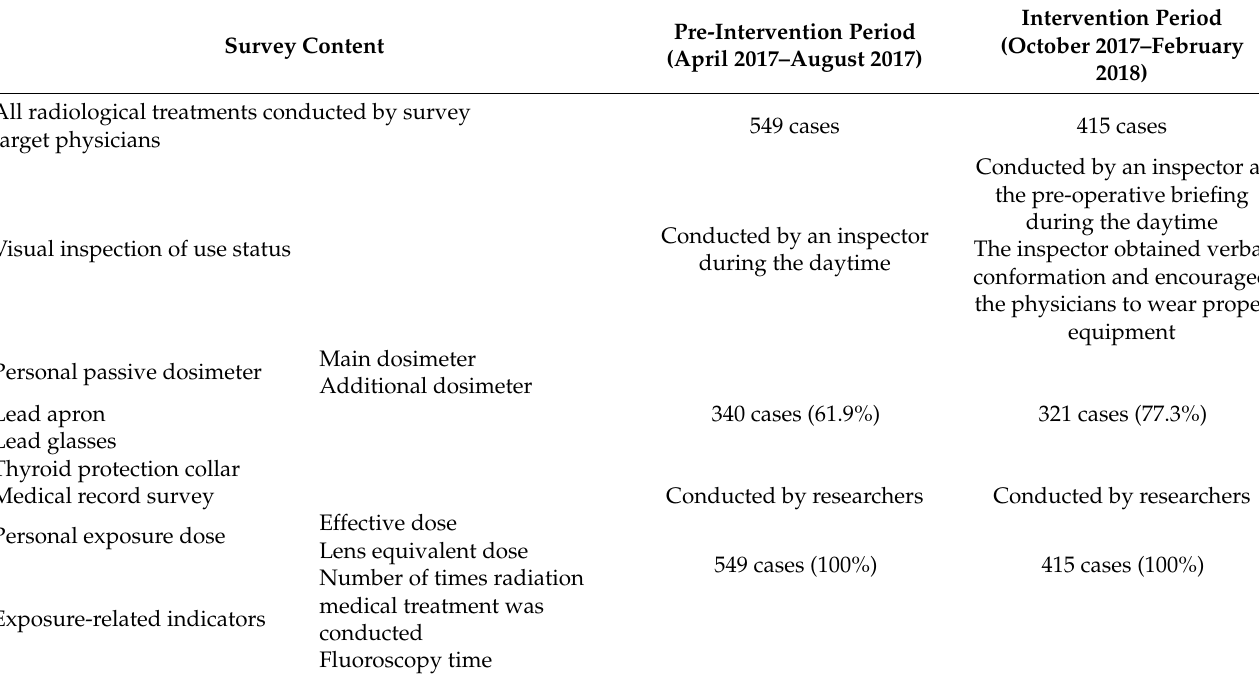
Table 3. Research